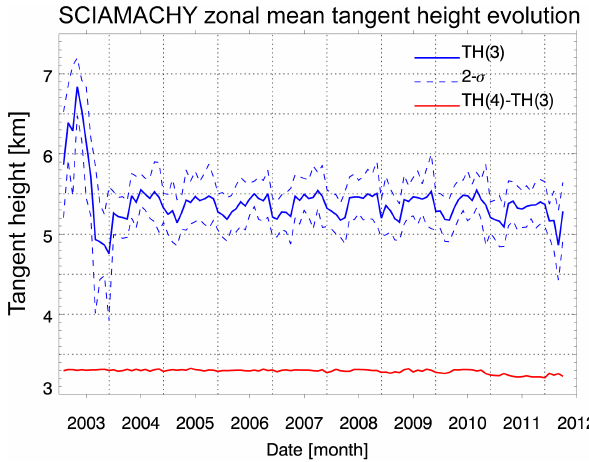
Figure 3. SCIAMACHY limb radiances from channels 4 (700– 789nm) and 6 (1000–1300nm) for tangent heights (TH) from 2.3 (violet) to 22.0km (orange). A measurement sequence of the EN- VISAT orbit 24382 (AZM 1) from 29 October 2006 (measurement start time 10:16:10.62UTC) at 46.8 ◦ latitude, 1.9 ◦ longitude, and 62.8 ◦ sun zenith angle from operational level 1c data version 7.04W (calibration parameters 0–5) has been used. The cloud retrieval wavelength bands around 750 and 1090nm are shown as vertical dashed-dotted black lines and the channel borders as grey lines. The largest intensity decrease in both bands is marked by the black ar- rows.